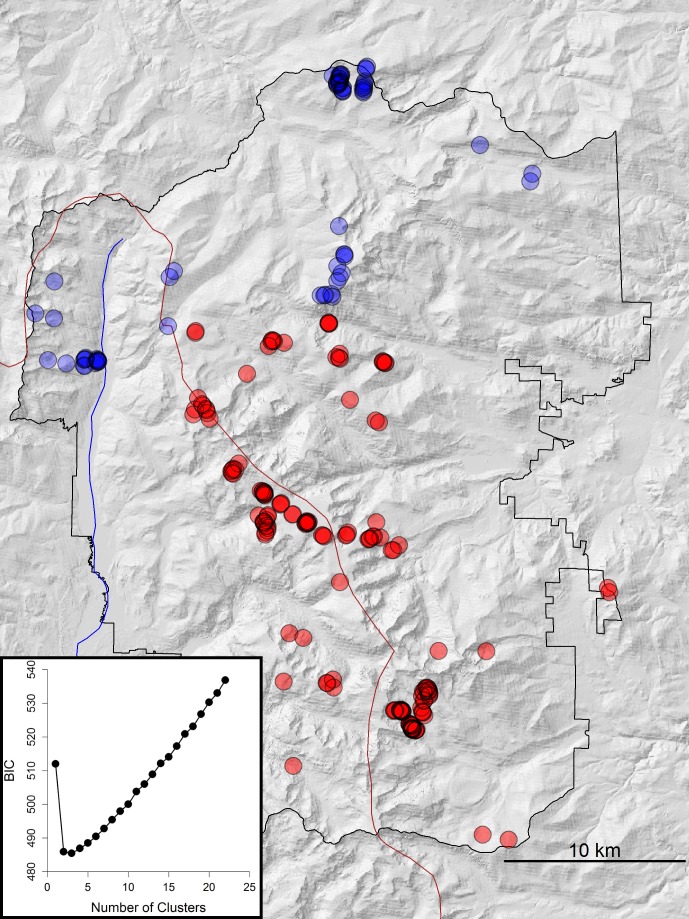
Results of the DAPC showing BIC support for two genetic clusters (inset) and assignment to either the north (blue) or south (red) clusters.Darker circles indicate multiple samples from that locality. Hillshade background was derived from the USGS National Elevation Dataset (https://nationalmap.gov).